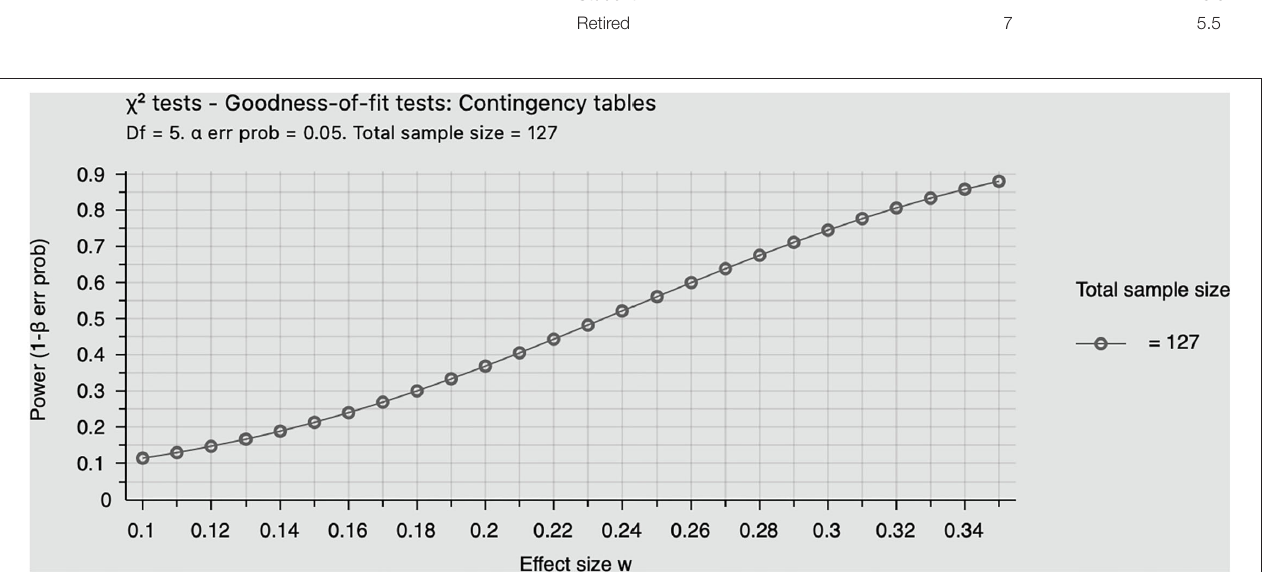
rank. Nevertheless, to date, no studies have analyzed fear and anxiety levels associated with endodontic experience related to differences in clinician